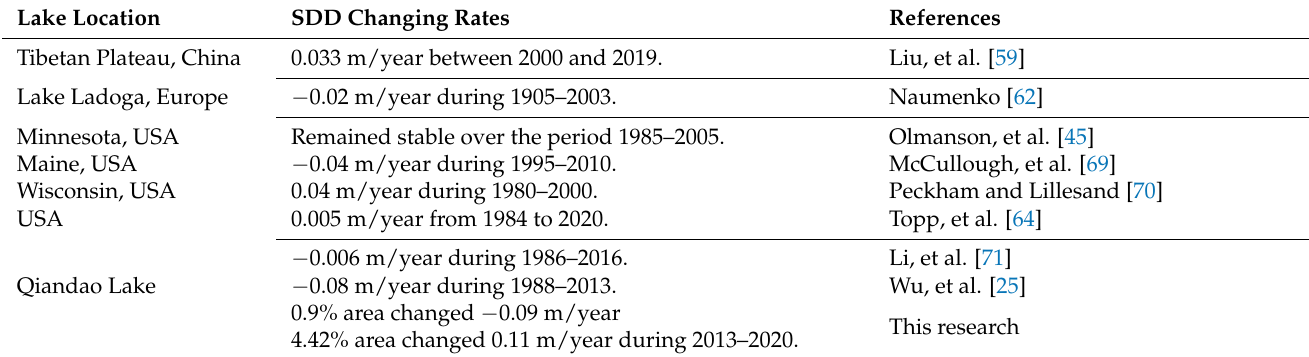
Table 3. SDD changing rates of lakes in different